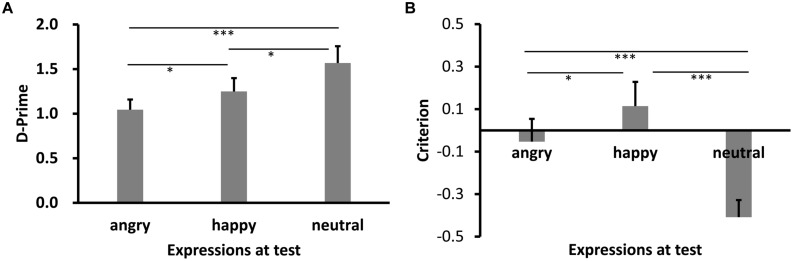
Sensitivity d′ (A) and Criterion c (B) results as a function of test expression (Experiment 1). Error bars represent 1 SEM. ∗p < 0.05;, ∗∗∗p < 0.001.